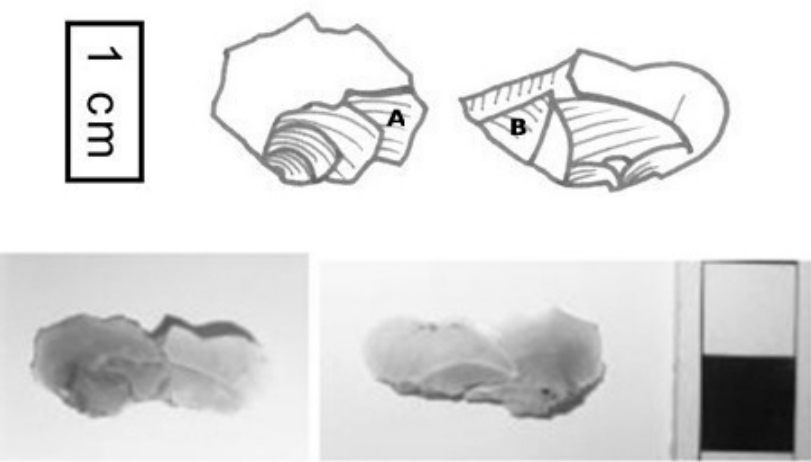
Figure 25. MP31 (11x16x3 mm) and MP37 (9x17x4 mm) conjoining pieces (A sits over B) indicative of the linear sequential reduction along an edge (drawing drawing and photograph by the